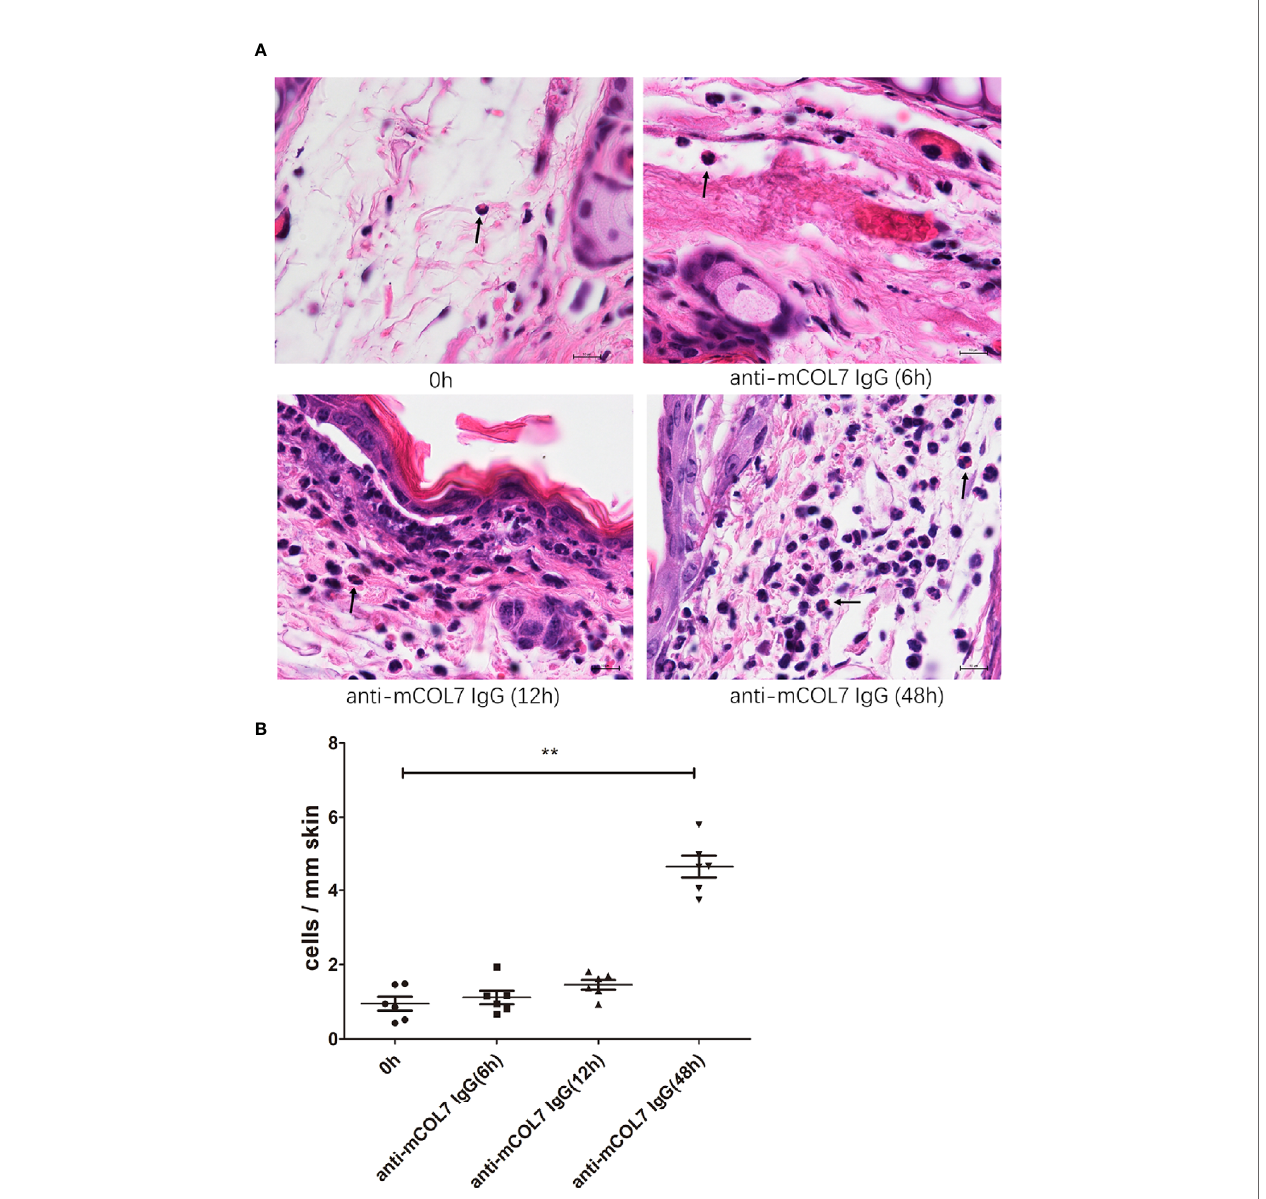
FIGURE 4 | Increased number of skin eosinophils 48 h after injection of anti-COL7 IgG. Female Balb/c mice were injected with 0.5 mg rabbit anti-mCOL7 IgG i.d. into ear skin. Mice were sacri fi ced and ear skin samples were collected before antibody injection (0 hours) as well as 6, 12 and 48 h after antibody injection. (A) Representative micrographs of H&E-stained ear skin sections collected at indicated time points. Black arrows indicate eosinophils. Scale bars = 10 m m. Quanti fi ed results of number of eosinophils per mm ear skin section are shown in (B) Three mice (6 ears) at each time point were sacri fi ced and used for analysis. Signi fi cant differences as determined by unpaired student t test between anti-mCOL7 IgG-treated ears and control IgG-treated ears are indicated are indicated (** p <